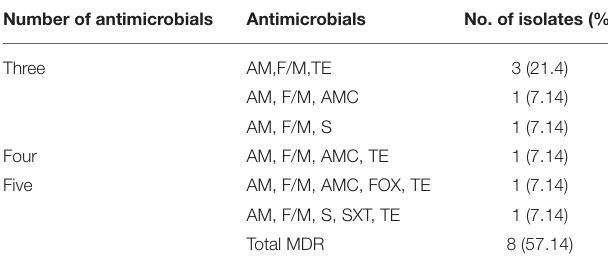
TABLE 4 | MDR profile of E. coli O157:H7 isolates. Number of antimicrobials